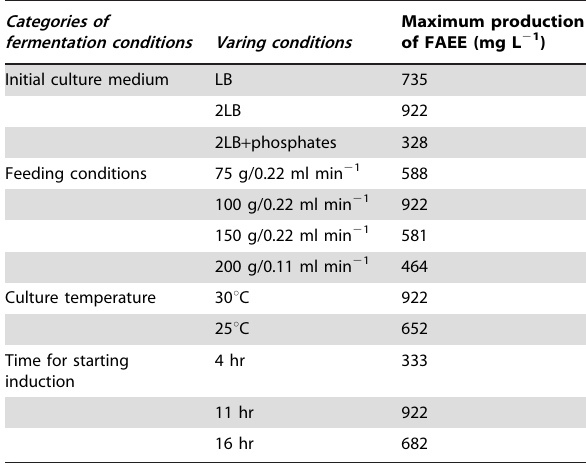
Table 1. FAEE production of E. coli mutant strain BL21 ( D fadE)/pXT11/pMSD8/pMSD15 under varied fed-batch fermentation conditions described in Materials and